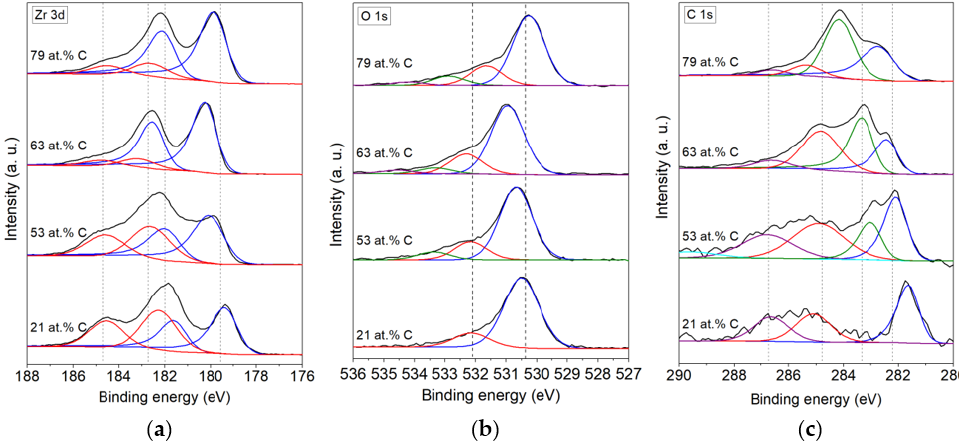
Figure 1. XPS spectra of Zr–C coatings of various carbon concentrations ( a ) Zr 3d, ( b ) O 1s, ( c ) C 1s.